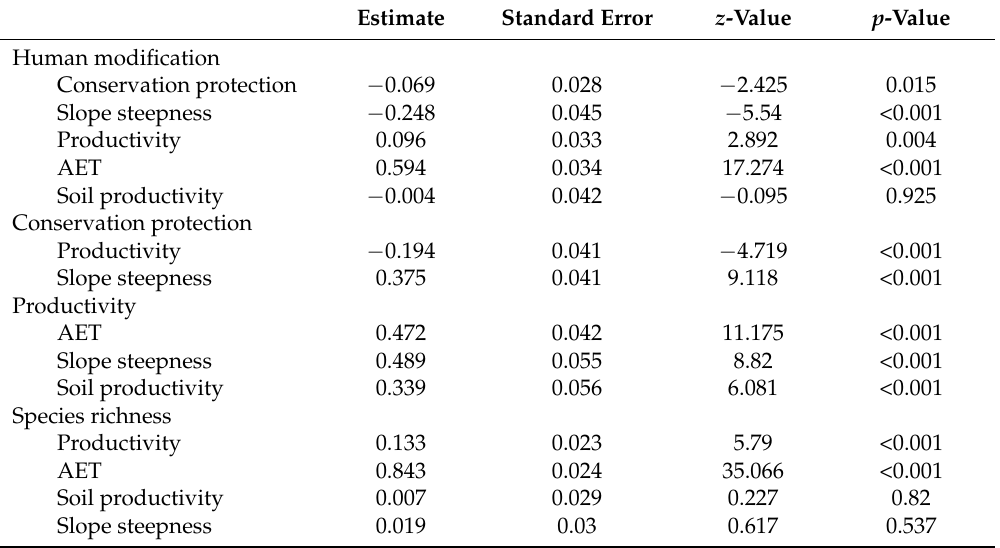
Table 1. Estimates of coefficients for relationships between factors in the proposed path diagram shown in Figure 1. Results are plotted in Figure